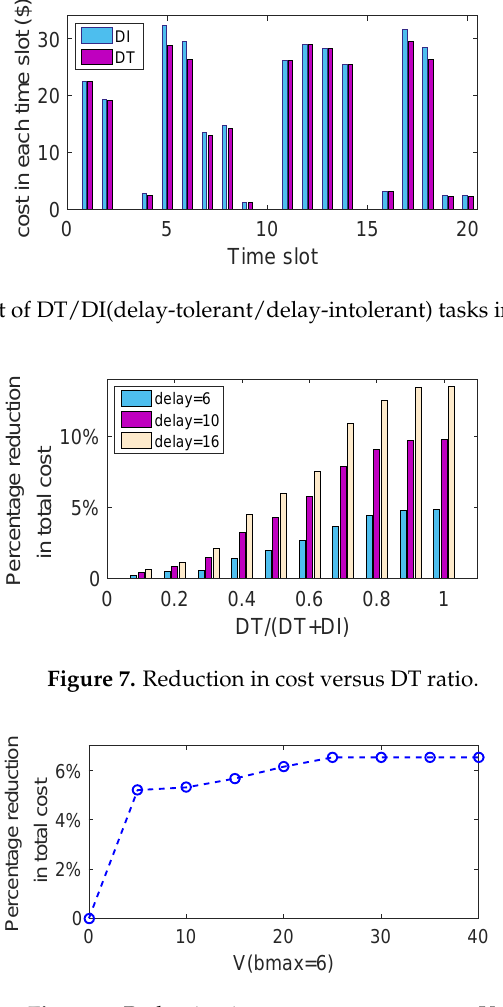
Figure 8. Reduction in cost versus parameter